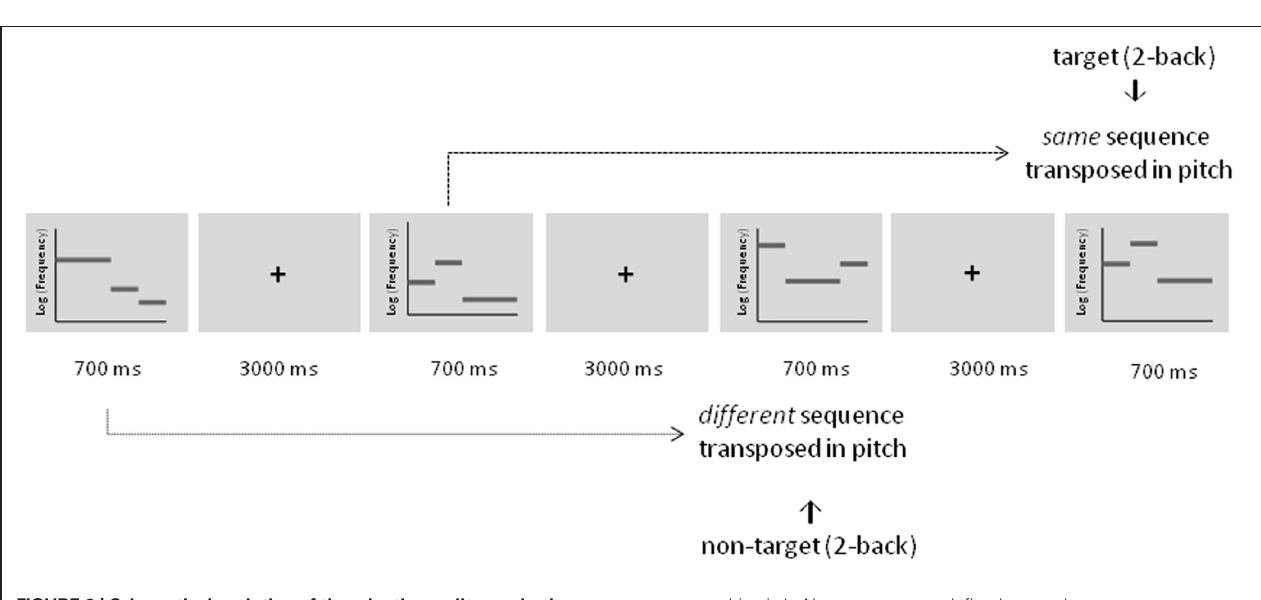
FIGURE 2 | Schematic description of the adaptive auditory n -back task during training illustrated for a 2-back condition. Targets were defined as tonal sequences comprising the same sequence that was